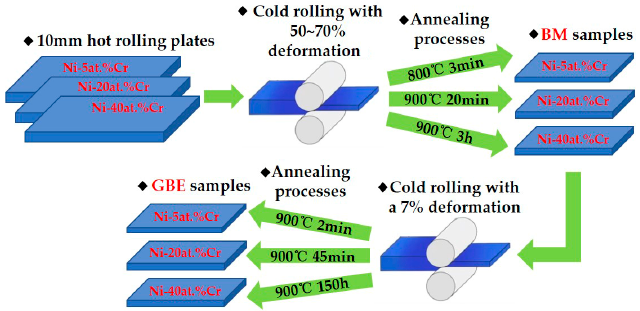
Figure 1. The diagram of the preparation process of BM and GBE